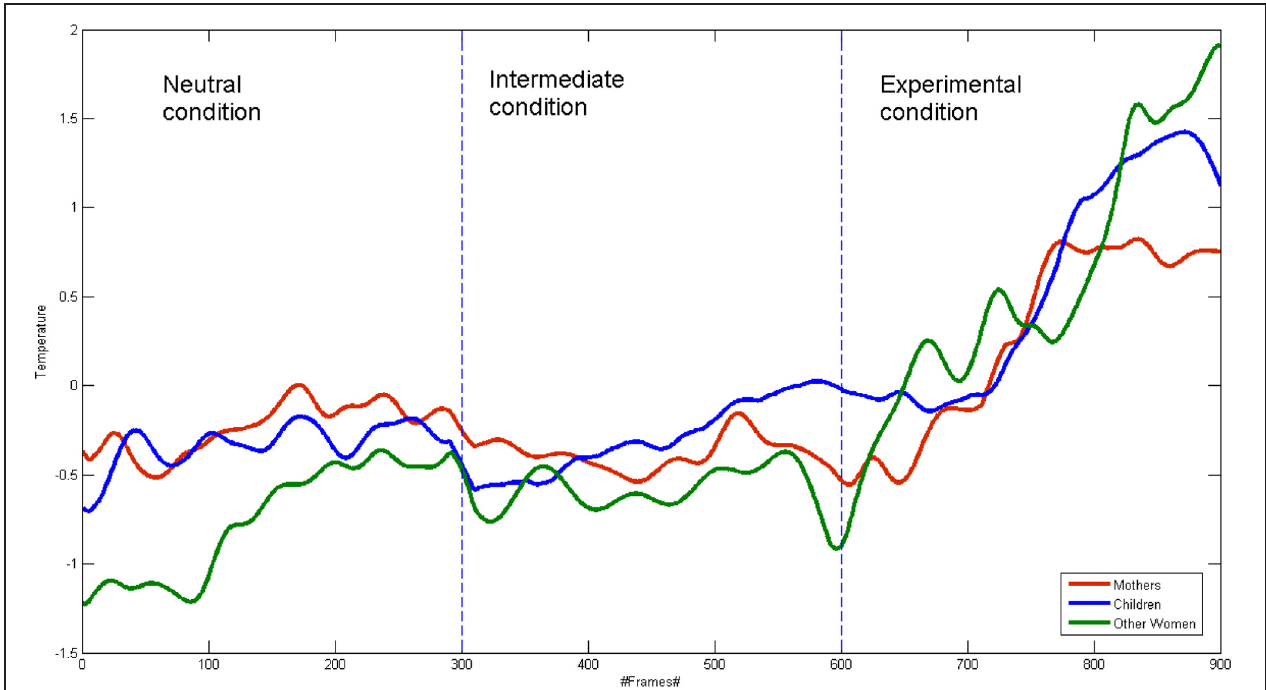
FIGURE 2 | Mean signals of mothers, other women and children for all the conditions.